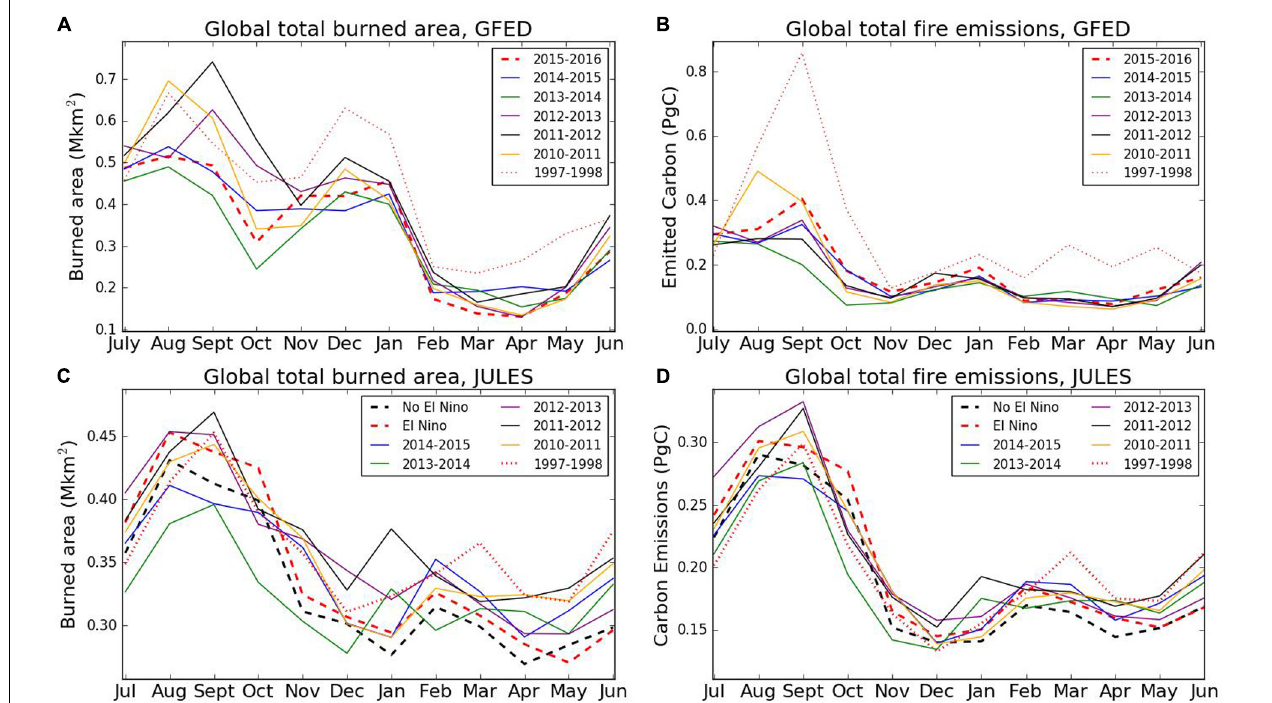
FIGURE 5 | GFED4.1s observations of global burned area (A) and fire emissions (B) , and JULES-INFERNO simulated global burned area (C) and fire emissions (D) , July–June from 2010 to 2016, plus 1997/98 (dotted). 2015–2016 is shown in red dashed (El Niño), and black dashed (No El Niño).